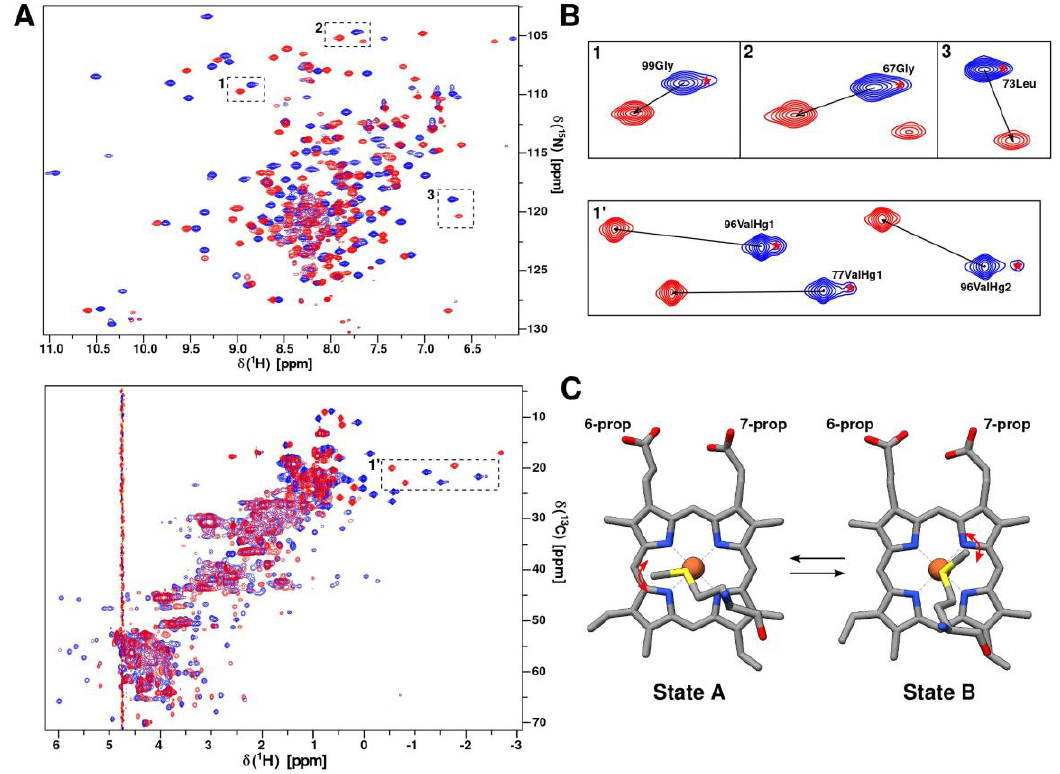
Figure 6. An axial heme methionine fluxionality. ( A ) Overlaid 1 H/ 15 N-HSQC (in top) and 1 H/ 13 C- HSQC-CT (in bottom) spectra of oxidized (blue) and reduced (red) forms of CytC552. ( B ) Selected regions of 1 H/ 15 N-HSQC (in top) and 1 H/ 13 C-HSQC-CT (in bottom) spectra with and without signal splitting for oxidized and reduced CytC552, respectively. The red asterisks indicate minor signals. ( C ) Two possible arrangements of heme-coordinating axial Met103 of CytC552 illustrating fluxionality (structures are taken from the NMR ensemble). Red arrows indicate methionine side-chain oscillation within a potential well of each